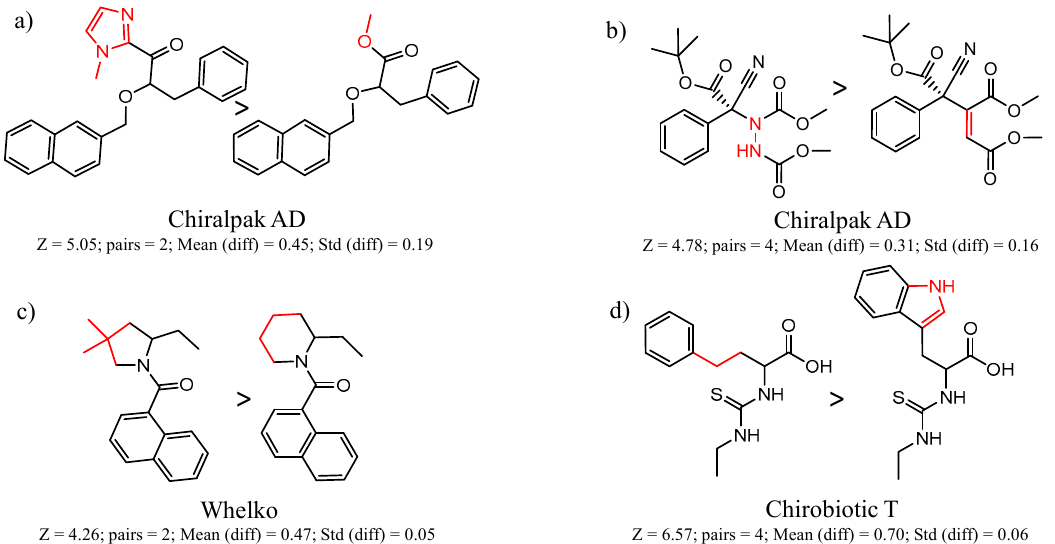
Figure 9. Matched Molecular Pairs illustrating difficult to categorize effects that would normally escape notice.